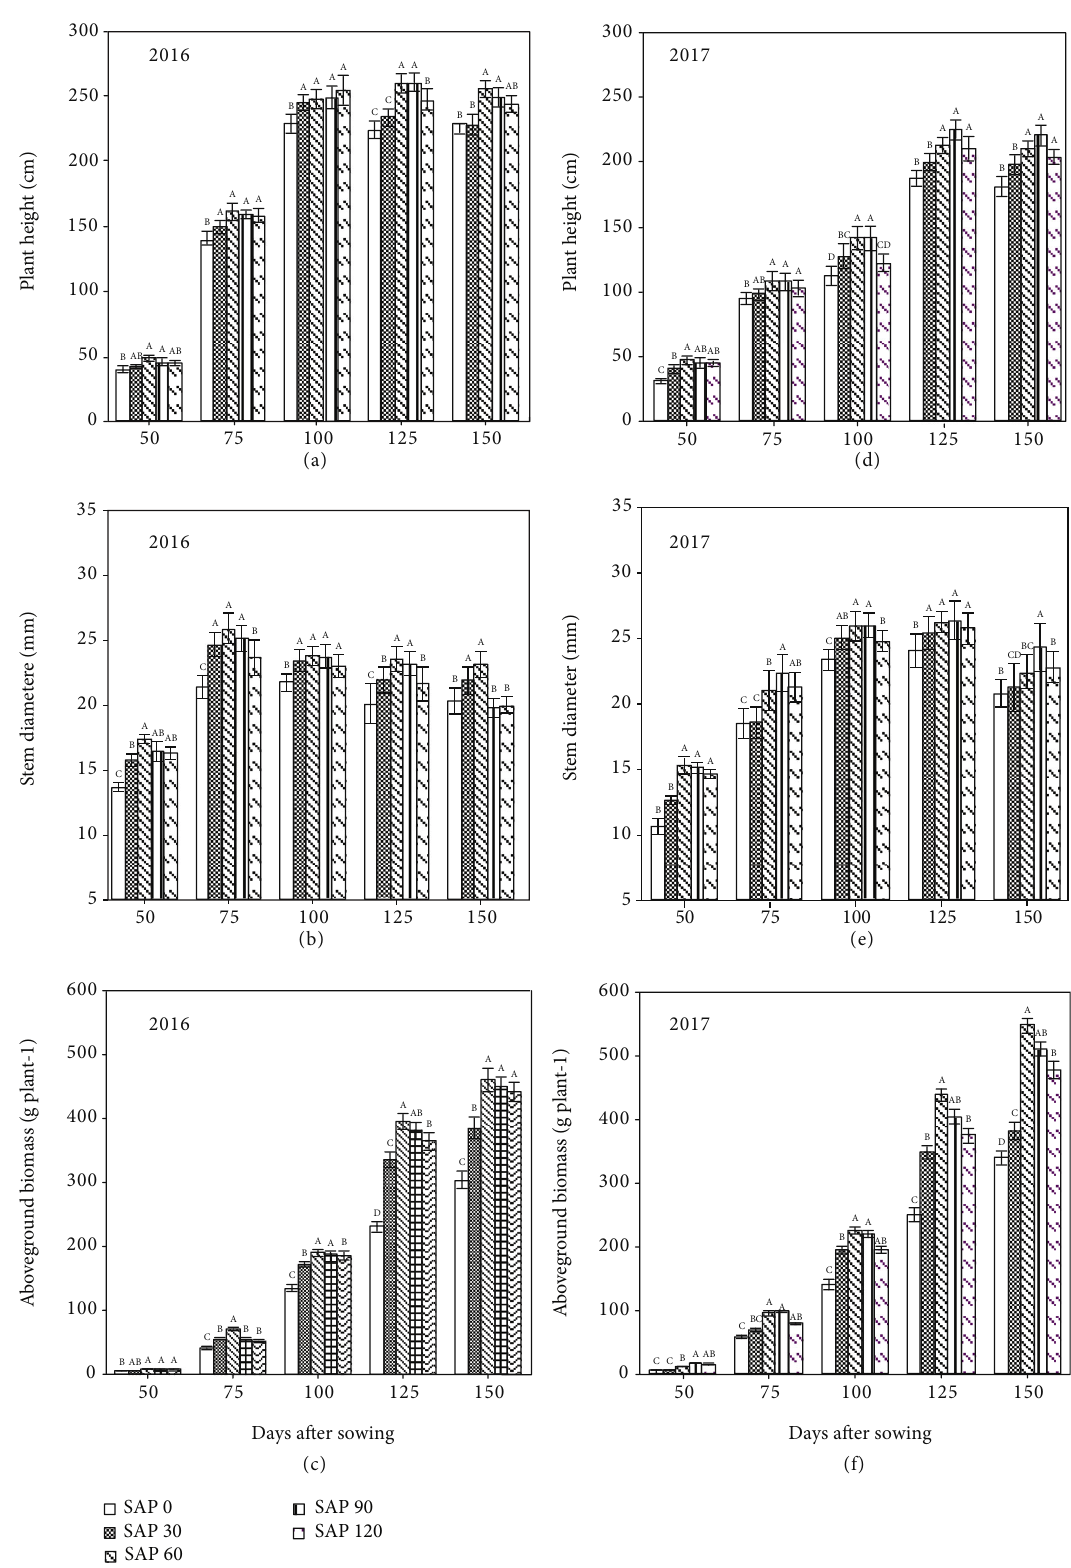
Figure 3: Maize plant height, stem diameter, and aboveground biomass under multifunctional SAP doses during the maize growing season in 2016 – 2017. SAP0 = SAP0kg ha – 1 ; SAP30 = SAP30 kg ha – 1 ; SAP60 = SAP60kg ha – 1 ; SAP90 = SAP90 kg ha – 1 ; and SAP120 = SAP 120kg ha – 1 . Horizontal bars represent signi fi cant di ff erence at the 0.05 probability level according to the least signi fi cant di ff erent test (LSD